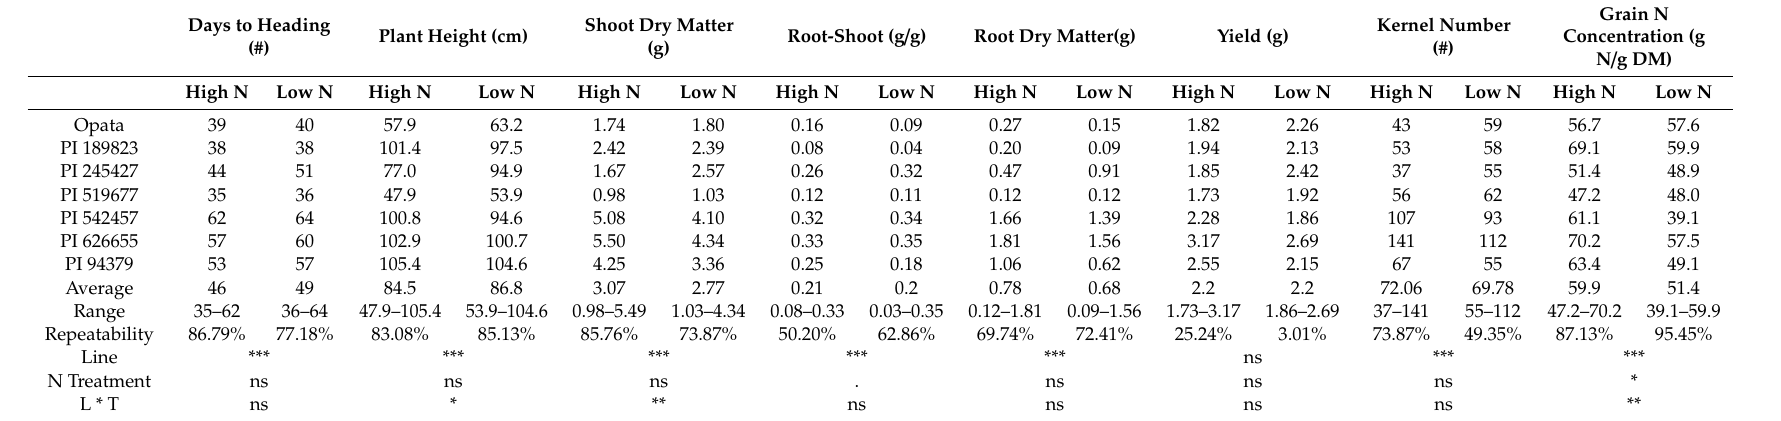
Table 1. Di ff erential responses of lines for eight traits in high N and low N environments in the maturity assay. The average, range, and repeatability of each trait was presented for each line. The significance of line, N treatment, and the line × N treatment interaction (L ×